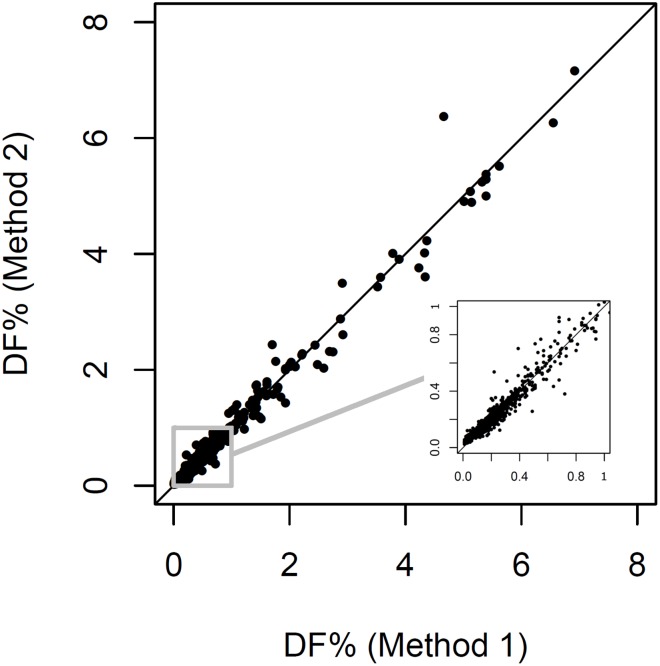
Equivalence of the “no donor genotype” algorithm for DF determination.Samples passing QC used in creation of the “no donor genotype” algorithm are shown (N = 1128). Inset magnifies the 0–1% range. Line shows equality.